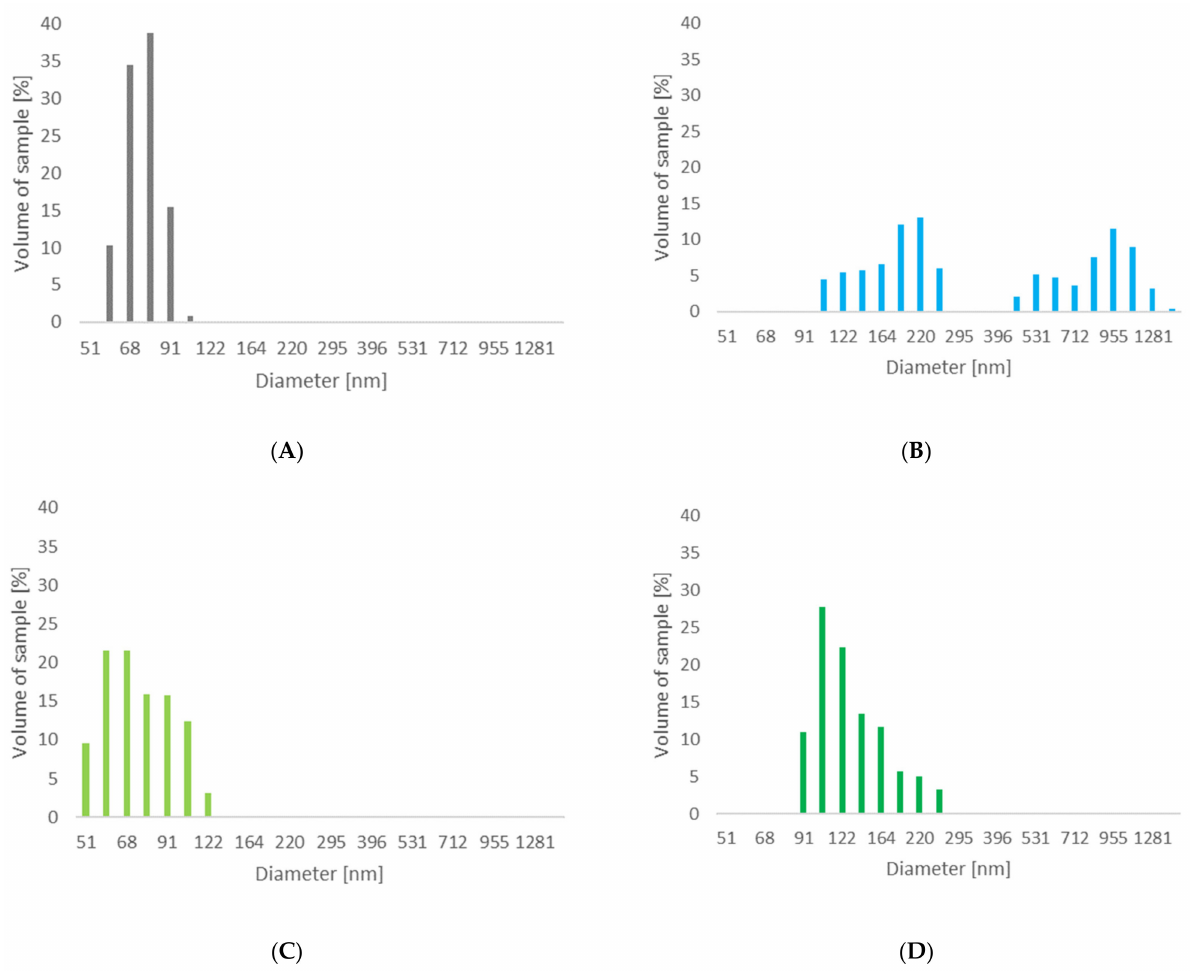
Figure 3. The particle size distribution of celluloses after enzymatic modification: ( A ) Cel_A-Tr, ( B ) Cel_A-Asp, ( C ) Cel_B-Tr, ( D ) Cel_B-Asp.